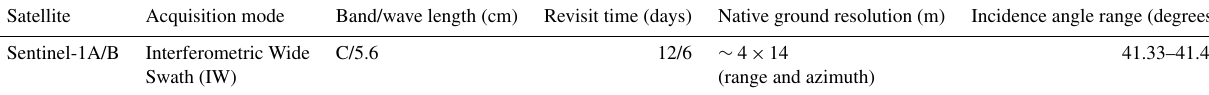
Table 1. Specifications of the Sentinel-1A/B images used in this study.